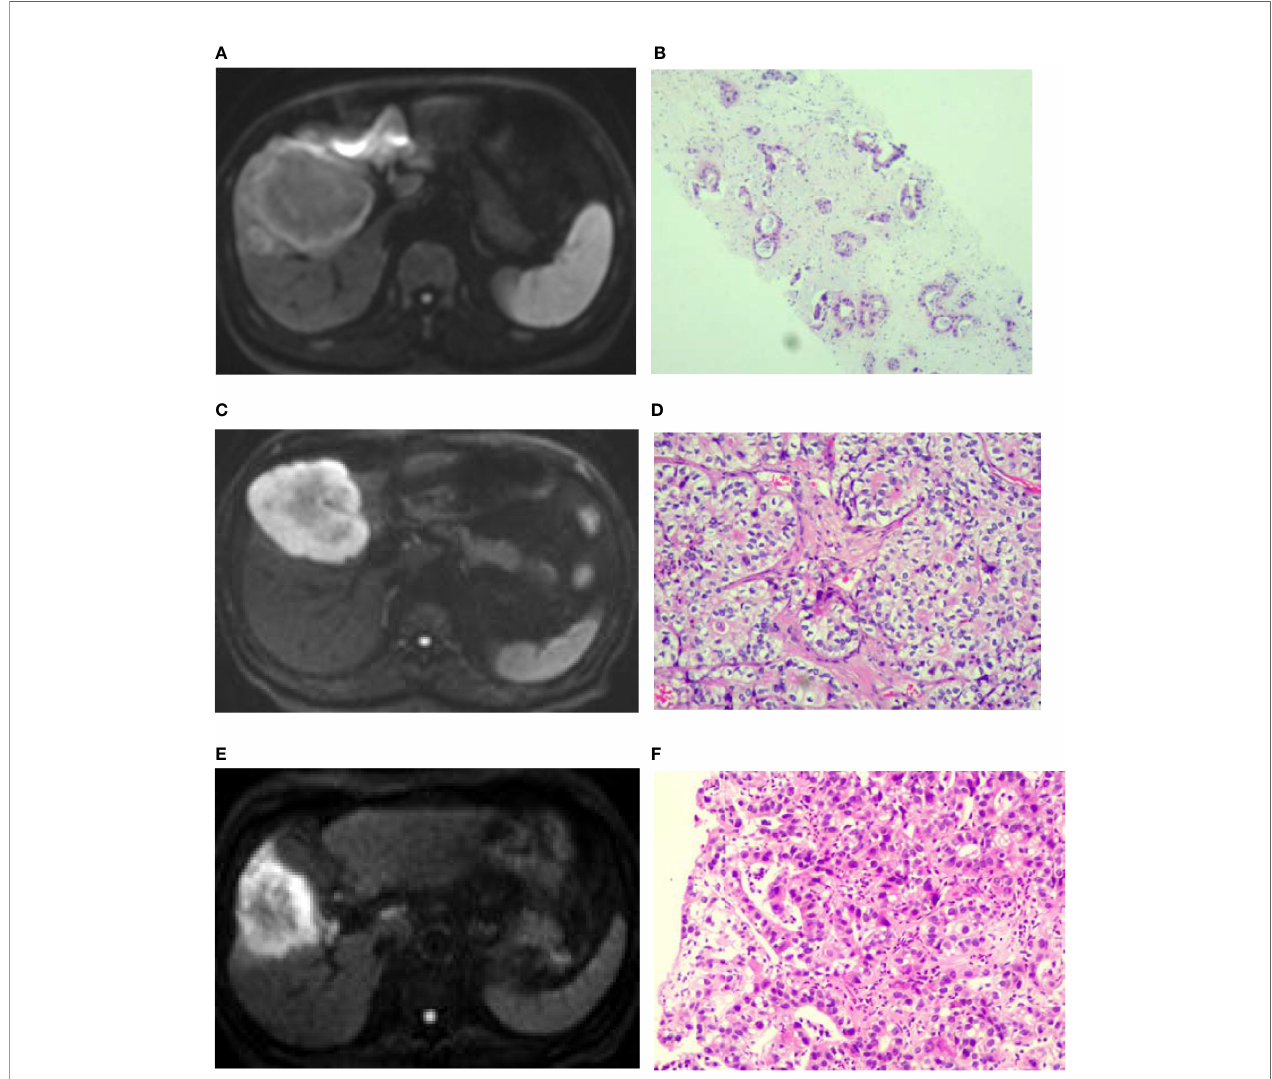
FIGURE 1 | Diffusion weighted imaging (DWI) of intrahepatic mass-forming cholangiocarcinomas (IMCCs) with different differentiations. (A, B) A target sign was shown in a well- differentiated IMCC lesion on DWI with peripherally relatively-hyperintense signal. (C, D) A target sign was shown in a moderately-differentiated IMCC lesion on DWI with peripherally relatively-hyperintense signal. (E, F) A target sign was shown in a poorly-differentiated IMCC lesion on DWI with peripherally relatively-hyperintense signal. Pathological staining: